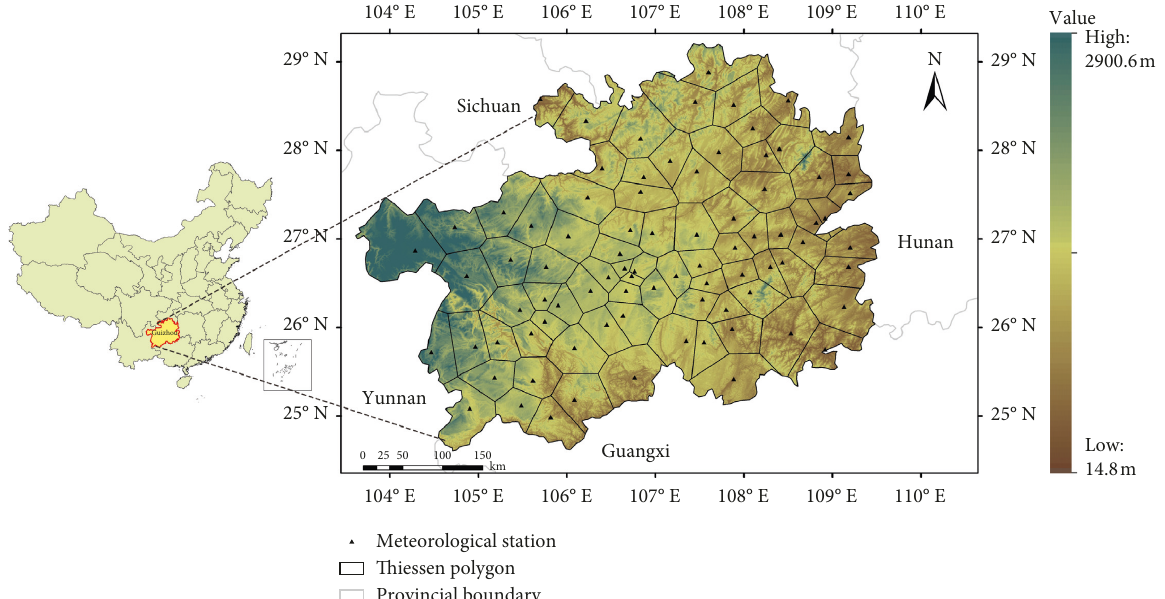
Figure 1: Location and meteorological monitoring points in Guizhou Province. Note: the figure includes the digital elevation model (DEM) data and the Thiessen polygons based on the location of the 84 weather stations.